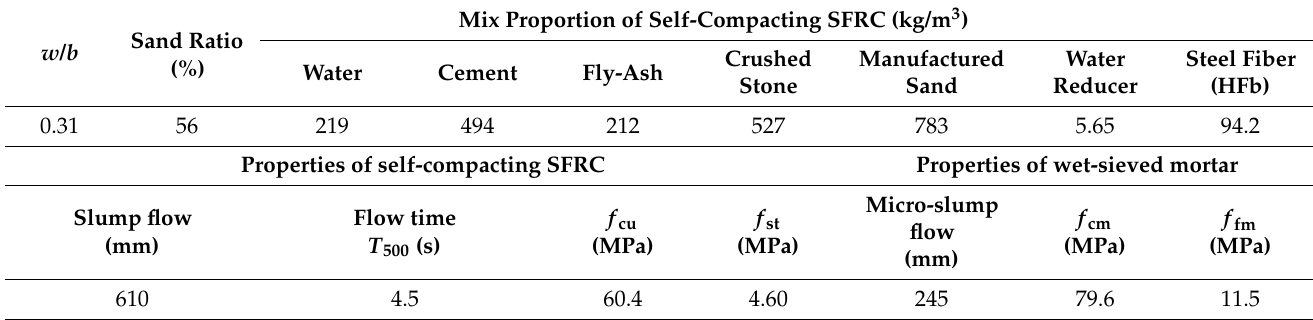
Table 2. The mix proportion and properties of self-compacting SFRC and wet-sieved mortar.